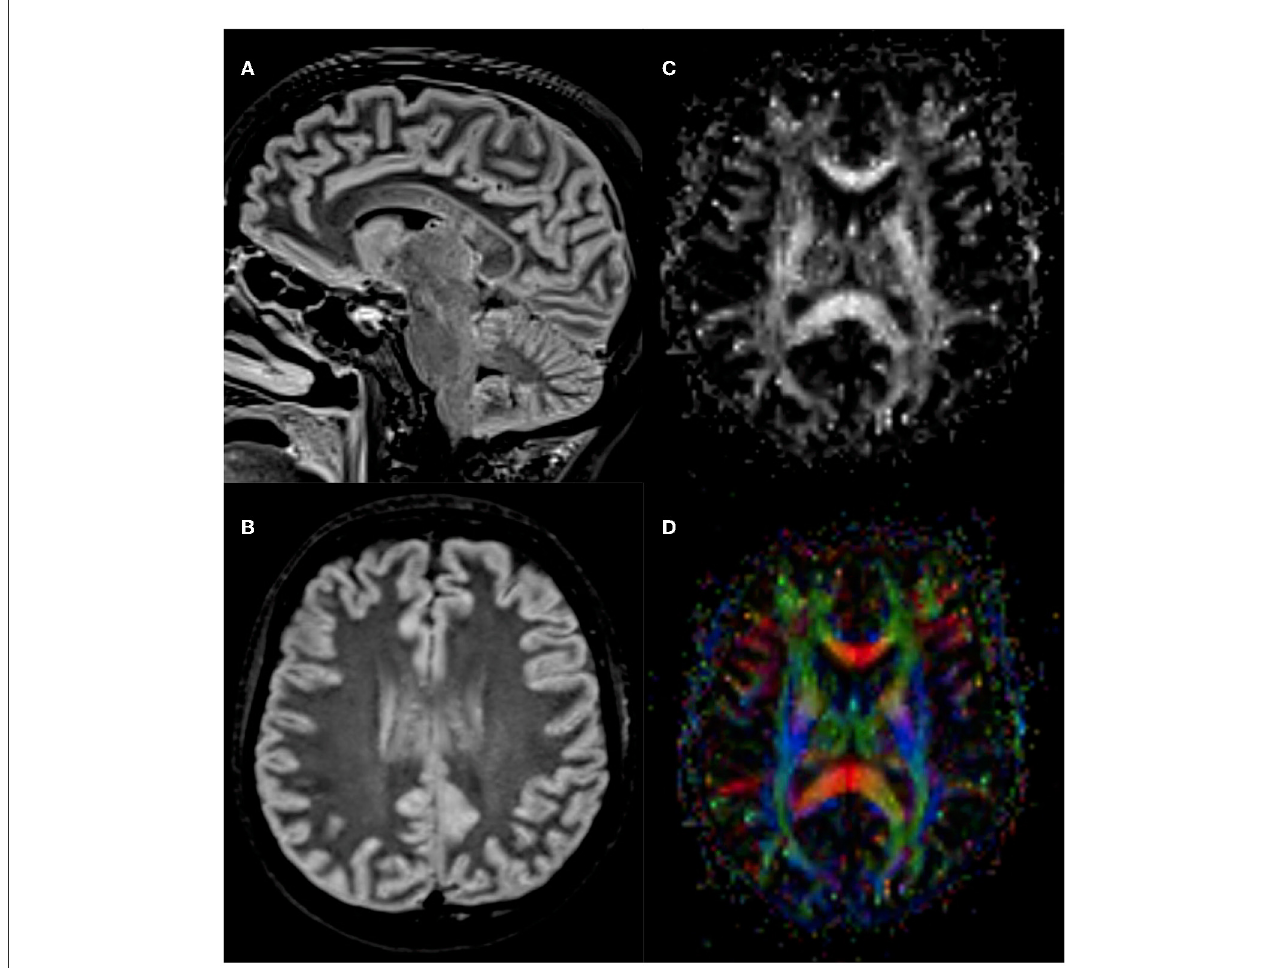
FIGURE2 Brain MRI findings. Axial (A) and sagittal (B) 1.5 Tesla T2-weighted fluid-attenuated inversion recovery (FLAIR) showed multiple focal punctate areas of hyperintensities localized in the splenium and isthmus of the corpus callosum, with no contrast enhancement or diffusion restriction. Follow-up 3 Tesla brain MRI revealed no T2-weighted abnormalities (images not shown). Yet, diffusion tensor imaging (DTI) showed fractional anisotropy reduction within the corpus callosum’s body and splenium (C, D)